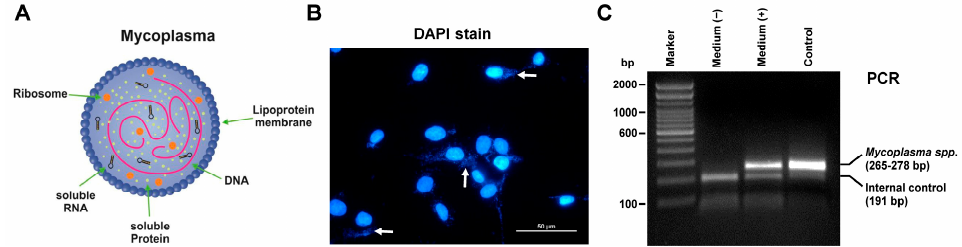
Figure 2. Detection of Mycoplasma spp. in cell culture supernatants. ( A ) Mycoplasmas are the smallest self-replicating bacteria devoid of a cell wall. They consist of a lipoprotein plasma membrane, ribosomes, and a genome consisting of a circular, double-stranded DNA molecule. ( B ) A monolayer of a mycoplasma-contaminated rat cell line was stained with DAPI and analyzed under a fluorescent microscope with an appropriate UV filter package (340/380 nm excitation) at a magnification of 400 × . Please note the very small bright extranuclear dots that are typical for mycoplasmas (marked by arrows). The scale bar represents 50 µ m. ( C ) In the depicted analysis, 2 µ L normal control medium (Medium ( − ) and 2 µ L medium taken from a Mycoplasma -infected cell line (Medium (+)) were tested for Mycoplasma infection using the Venor ® GeM OneStep kit (#11-8050, Minerva biolabs GmbH, Berlin, Germany) according to the manufacturer’s instructions. As a positive control, 2 µ L of the positive control included in the kit system was co-amplified. The internal control in each sample resulting in an amplicon of 191 bp in size demonstrates the functionality of the PCR reaction, while an amplicon of 265–278 bp in size indicates a contamination with Mycoplasma spp . The PCR products were separated on a 2% standard agarose gel containing ethidium bromide and amplicons visualized using a standard gel